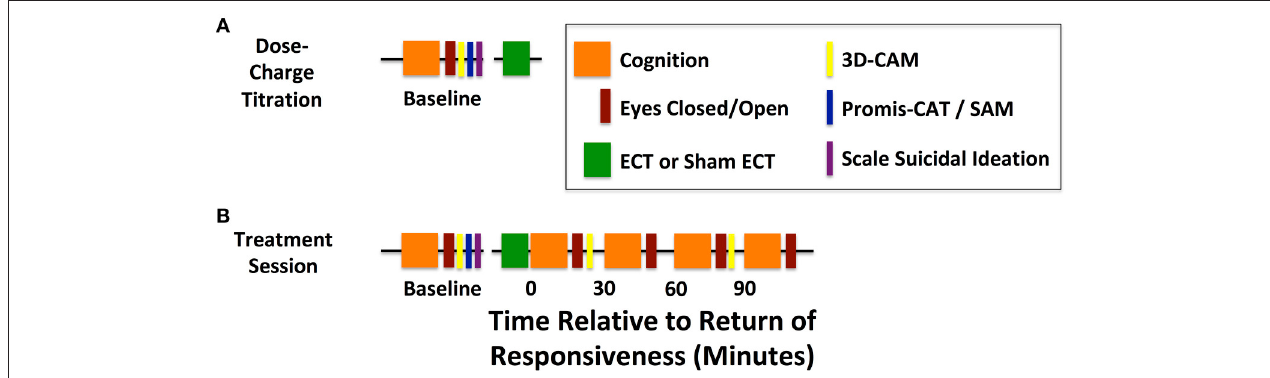
FIGURE 2 | Timelines for dose-charge titration and treatment sessions . (A) Baseline cognitive assessments are acquired before the dose-charge titration session with etomidate general anesthesia. (B) Baseline cognitive assessments are acquired before each treatment session and serially from the return of responsiveness to verbal command (T = 0) and up to 90min afterwards (T = 90). Continuous high-density EEG is acquired during baseline assessments and treatment sessions.